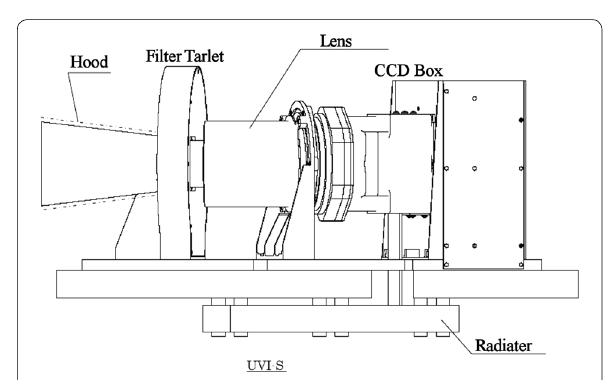
Fig. 2 Schematic layout of